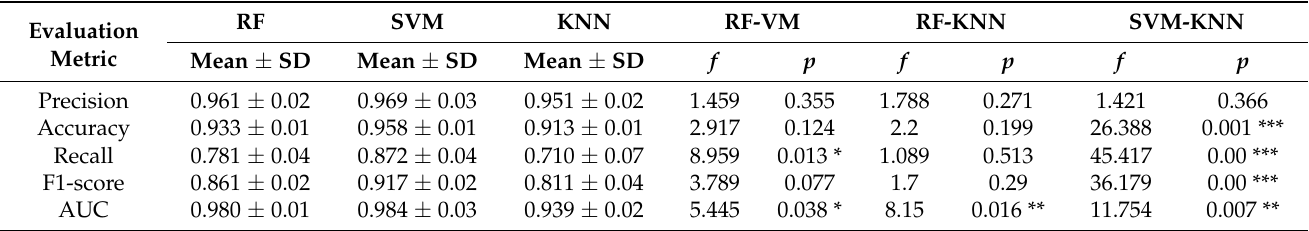
Table 6. Comparison of classification models in different evaluation